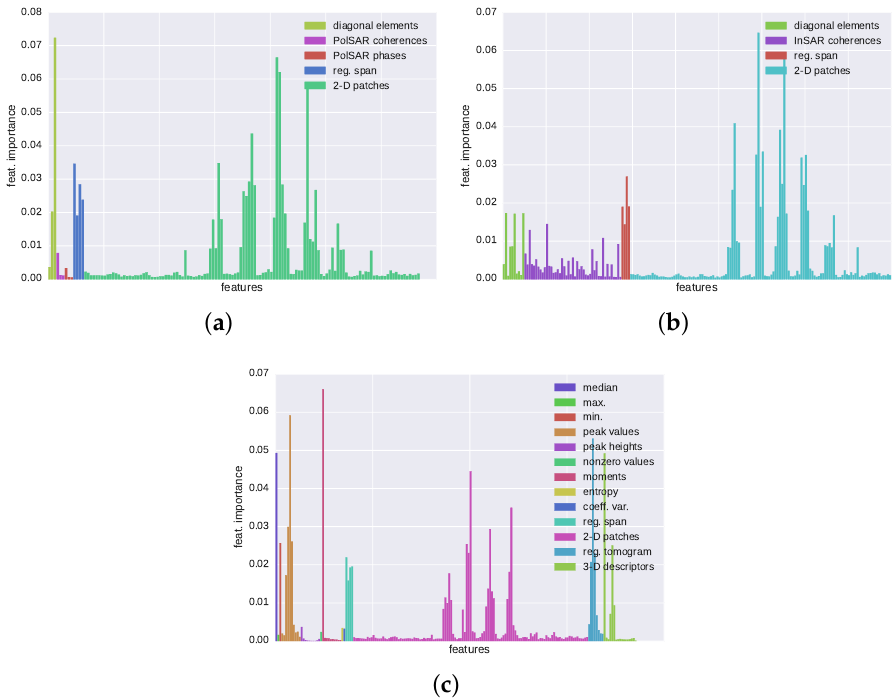
Figure 10. Feature importances for classification with RF. ( a ) PolSAR CM; ( b ) TomoSAR CM; ( c ) Tomogram.